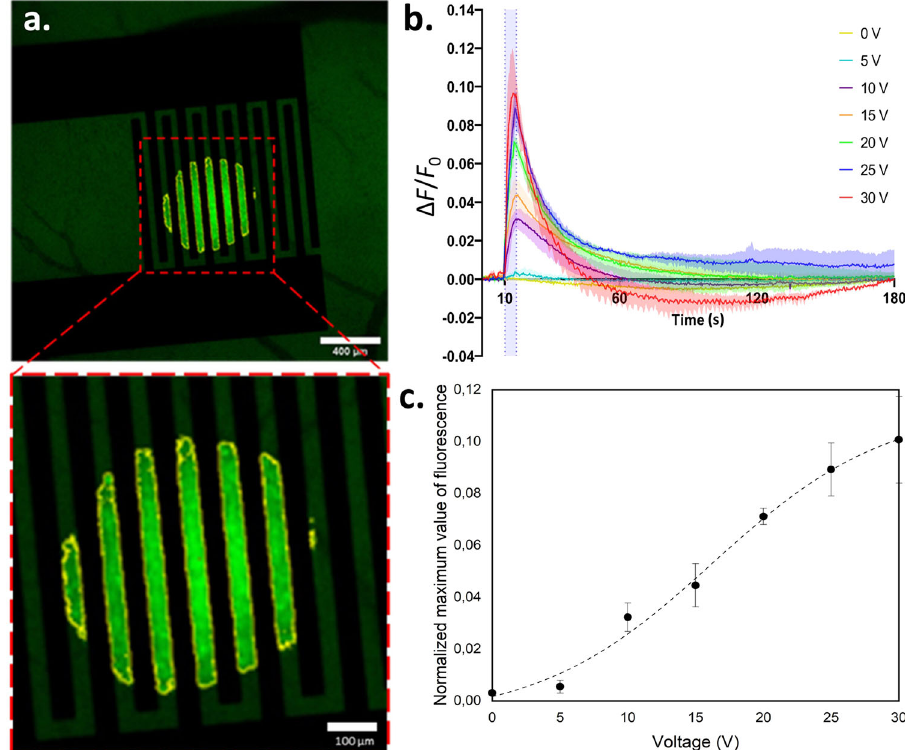
Fig. 5 Effect of PEFs on calcium signaling. a Picture from the top of the device placed on a U87-GCaMP6f spheroid grafted in the CAM observed at λ exc = 490 nm and a zoom on the region of interest. The fl uorescence is measured on the ROI depicted in yellow. Scale bars are respectively 400 µm and 100 µm. b Normalized fl uorescence intensity measured over time depending on the voltage applied. c Dose – response: maximum fl uorescence change depending on the voltage applied: 0 V ( n = 7), 5 V ( n = 5), 10 V ( n = 4), 15 V ( n = 5), 20 V ( n = 3), 25 V ( n = 3), 30 V ( n = 2). Error bars indicate standard